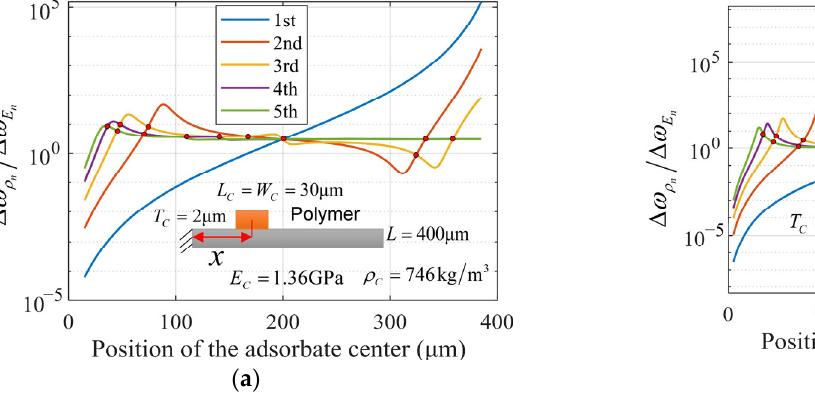
Figure 6. The ratio of the frequency shift caused by added density to the frequency shift caused by added Young’s modulus. ( a ) The curves are simulated with parameters in Table 1, the material of the adsorbate is polymer ( b ) The curves are simulated with parameters in Table 3, the material of the adsorbate is platinum.